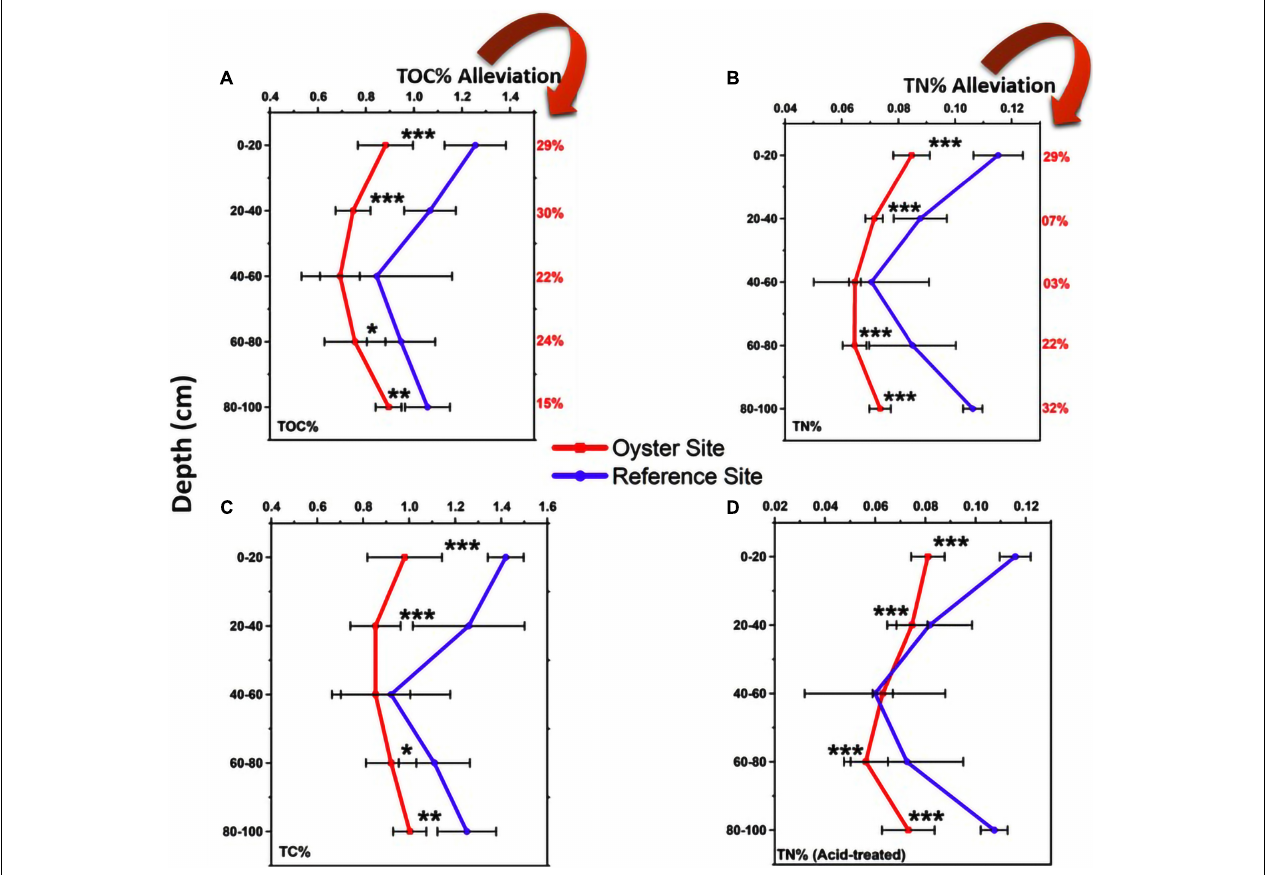
FIGURE 2 | Total carbon and nitrogen. (A) TOC%: Total organic carbon is shown in five sediment layers from top to bottom at both the oyster site and control site. The (B–D) are total nitrogen (TN)%, TC%, and TN% (acid-treated), respectively. In this image, the red color shows the nutrient status at the oyster site, and the purple color shows the nutrient change in the reference site. Error bars denote standard deviation (SD) of the mean ( n = 90). The statistical significance were set at three levels: P < 0.05 (*), P < 0.01 (**), and P < 0.001